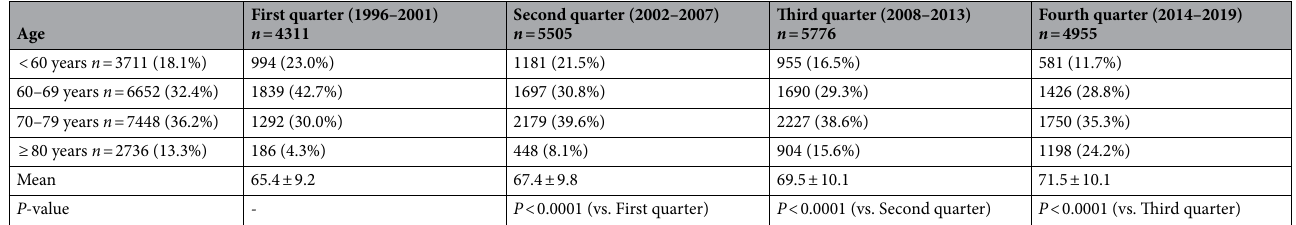
Table 3. Age distribution of new hepatocellular carcinoma cases in each quarter. Data are presented as counts (%) or mean ± standard deviation.